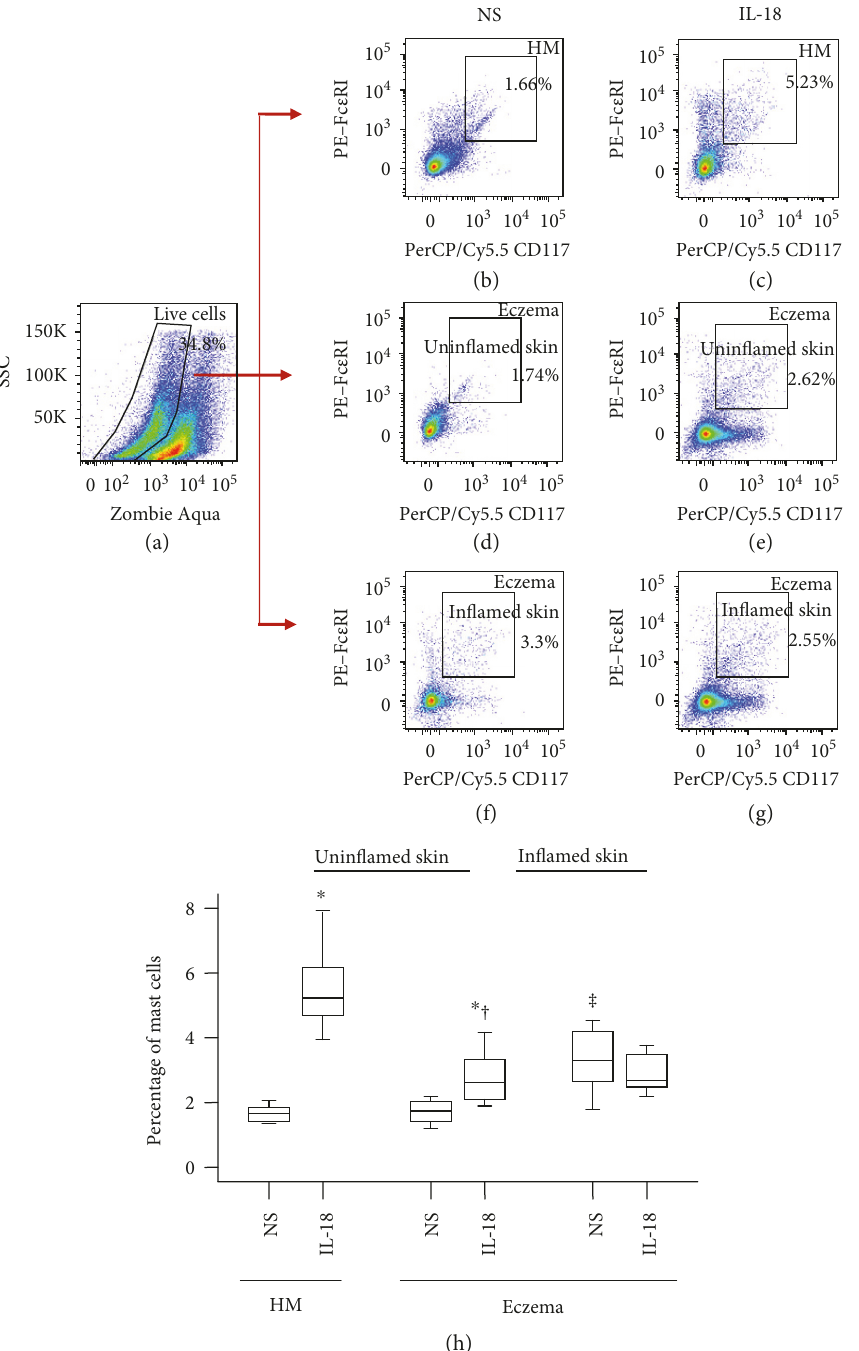
Figure 3: Flow cytometry analysis of the expression of IL-18 in dispersed skin mast cells of mice. Mice were treated with OVA solution for 3 weeks. For control experiments, healthy mice received NS only instead of OVA solution. After IL-18 or NS being injected subcutaneously around skin lesion area for 3 h, skin tissues of 3 × 3cm 2 around and far away from the injection site were removed and digested. Dispersed skin mast cells were then analyzed by fl ow cytometry. (a) represents gating strategy for live cells; (b), (d), and (f) show percentage of mast cells in skin of healthy mice (HM) and in normal or in fl ammatory skin of eczema mice treated with normal saline (NS), respectively. (c), (e), and (g) show percentage of mast cells in skin of healthy mice (HM) and in normal or in fl ammatory skin of eczema mice treated with IL-18 (10 ng/ml), respectively. (h) represents median percentage values of mast cells in mouse skin. Data shown are the median (range) value from 6 di ff erent mice. ∗ P < 0 05 in comparison with NS group. † P < 0 05 compared with HM IL-18 group. ‡ P < 0 05 compared with HM NS group (paired Mann – Whitney U